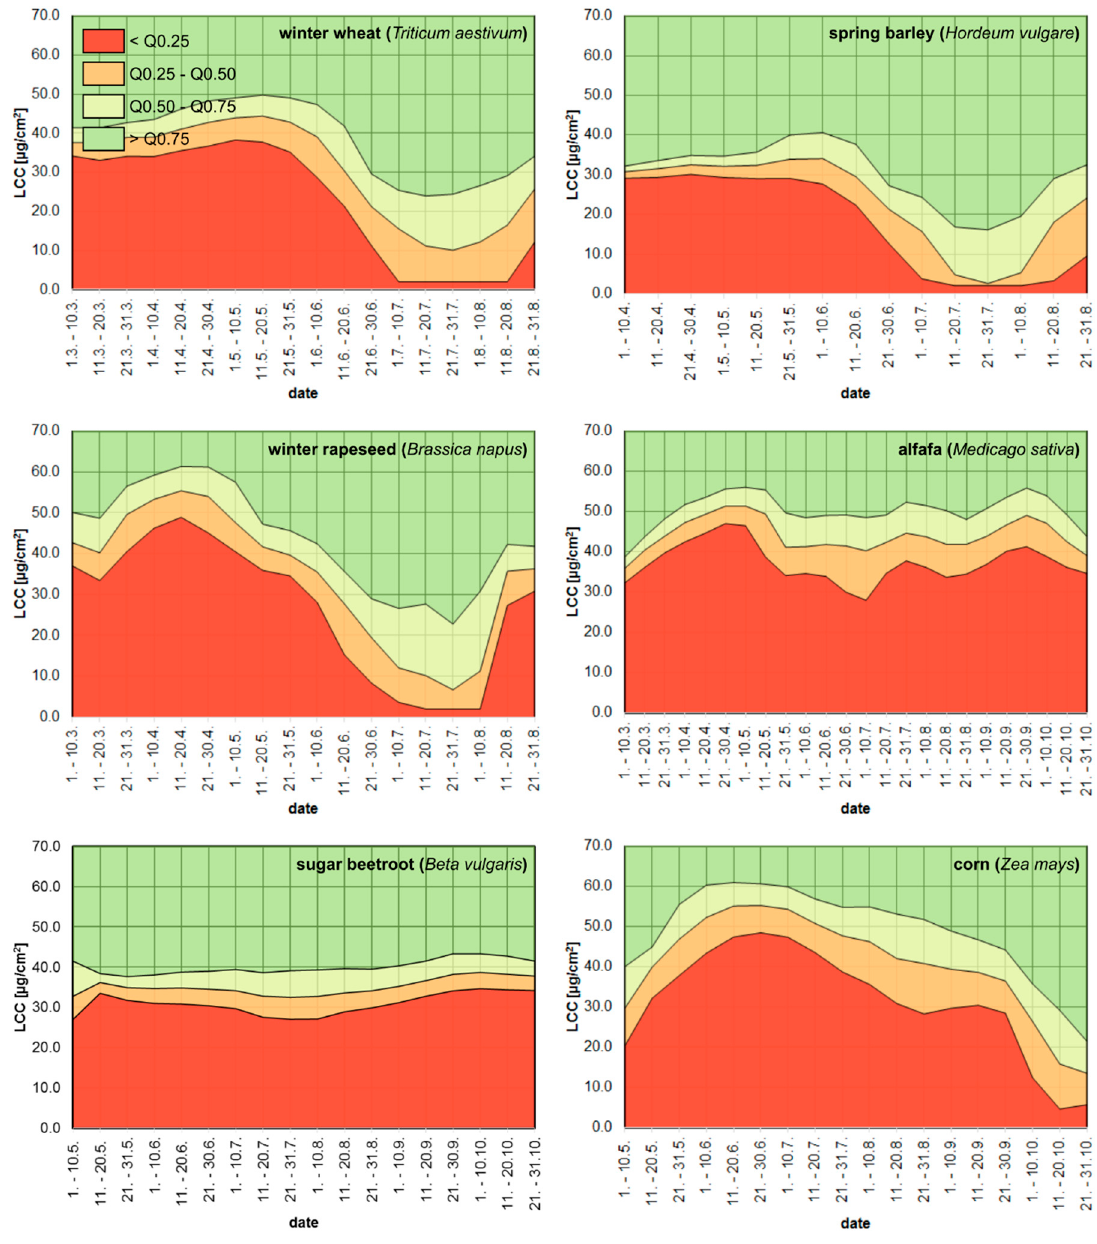
Figure A5. Temporal changes in estimated leaf chlorophyll content (LCC) values for all six crops of interest demonstrated using Q0.25, Q0.50, and Q0.75 quantiles.